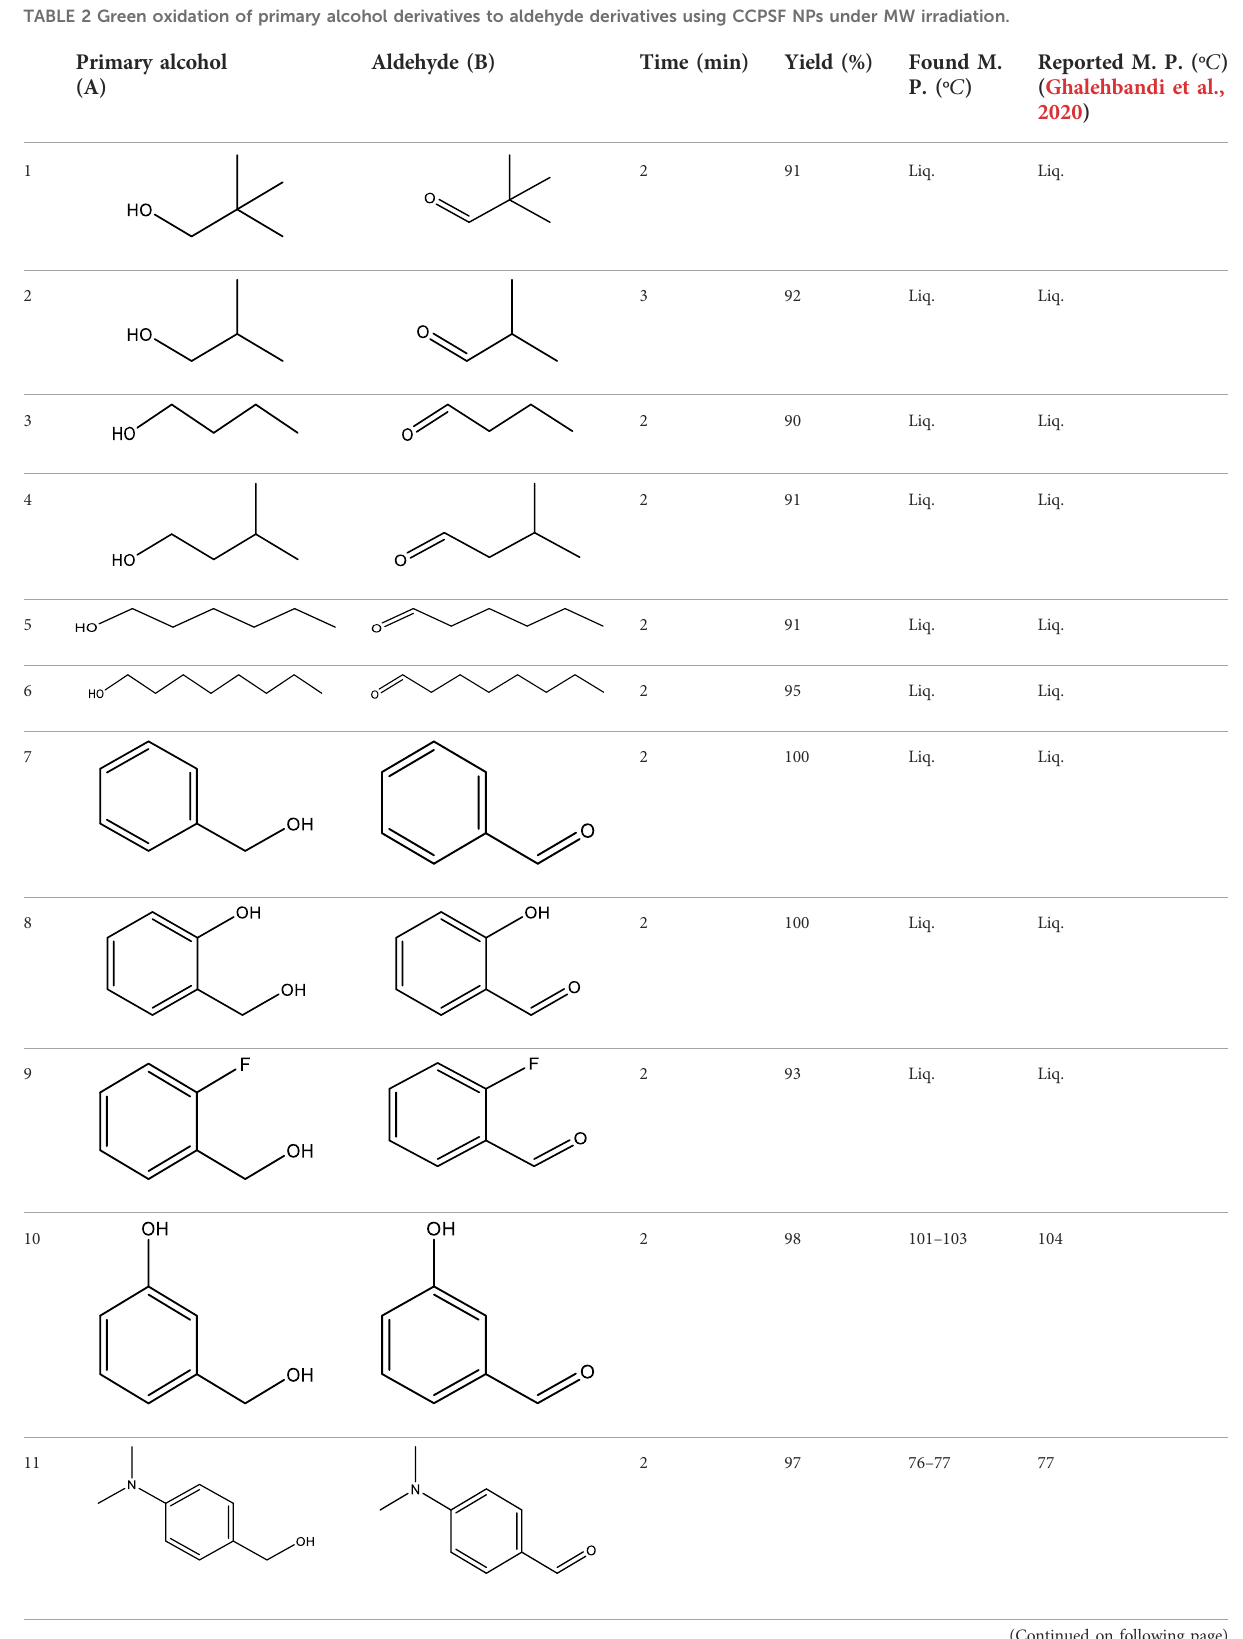
TABLE 2 Green oxidation of primary alcohol derivatives to aldehyde derivatives using CCPSF NPs under MW